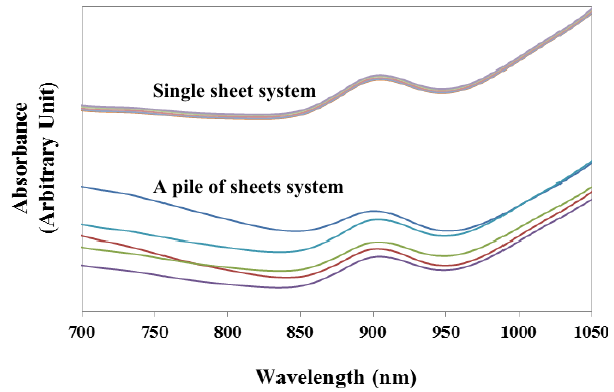
Fig. 6. Comparison of NIR spectra of a raw rubber sheet measured 5 times with single sheet system and a pile of sheets